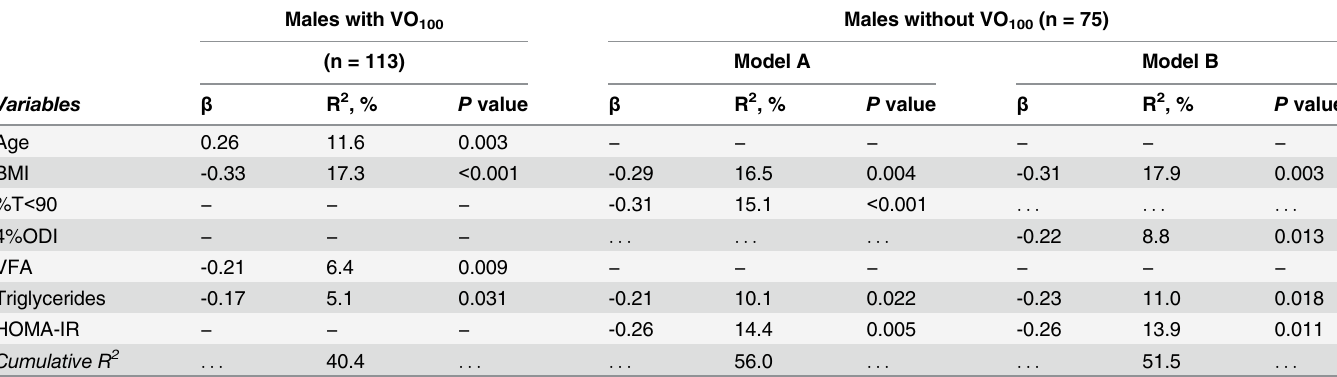
Table 4. Stepwise multiple regression models for CT LFA in males with and without VO 100. Males with VO